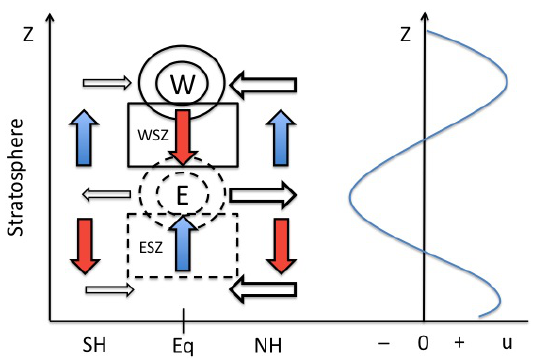
Fig. 9. Sketch of the QBO secondary meridional circulation on the left and the zonal wind profile at the Equator on the right. Arrows in- dicate vertical and meridional motion with colours meaning warm- ing (red) and cooling (blue). Below the altitude of maximum easter- lies (E) air is rising faster in the easterly shear zone (ESZ). At the al- titude of maximum easterlies air is diverging towards the poles and increases the speed of the BDC, the opposite is found at the altitude of maximum westerlies (W) where air converges at the Equator (Eq) and leads to downdrafts below that level which decrease the speed of the ascent and warm the atmosphere inside the westerly shear zone (WSZ). From our results of the hemispheric asymmetry in the meridional BDC-branch we conclude that the secondary meridional circulation is less strong in the SH by a factor of 2 and reduced the arrows accordingly in size. Figure adapted from Choi et al. (2002); Plumb and Bell (1982); Punge et al. (2009).